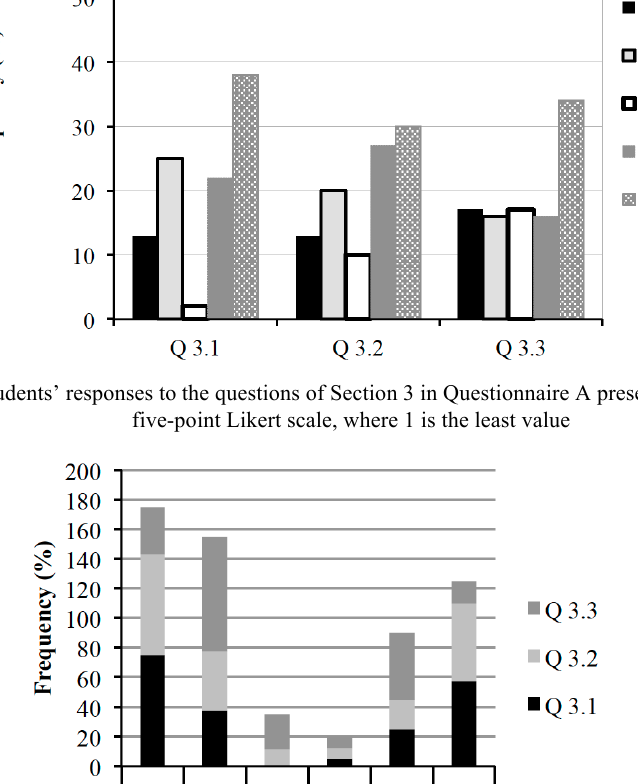
iJEP ‒ Vol. 7, No. 1,